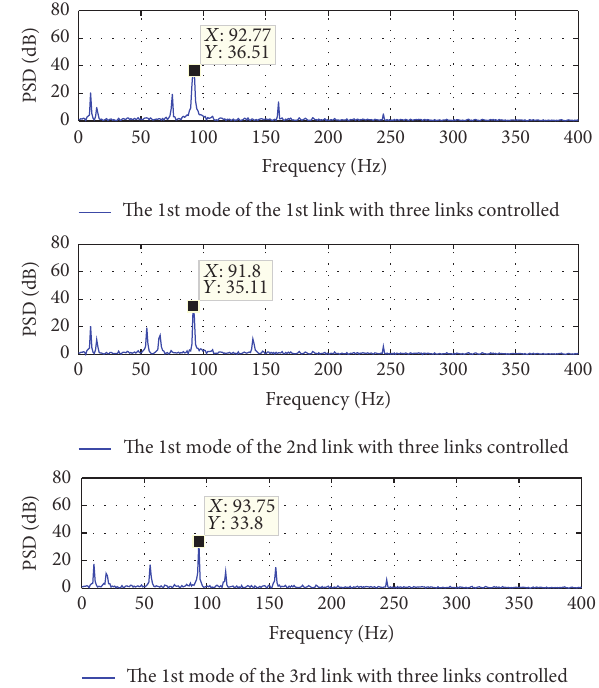
Figure 14: The PSD plot of the first mode of the three links with